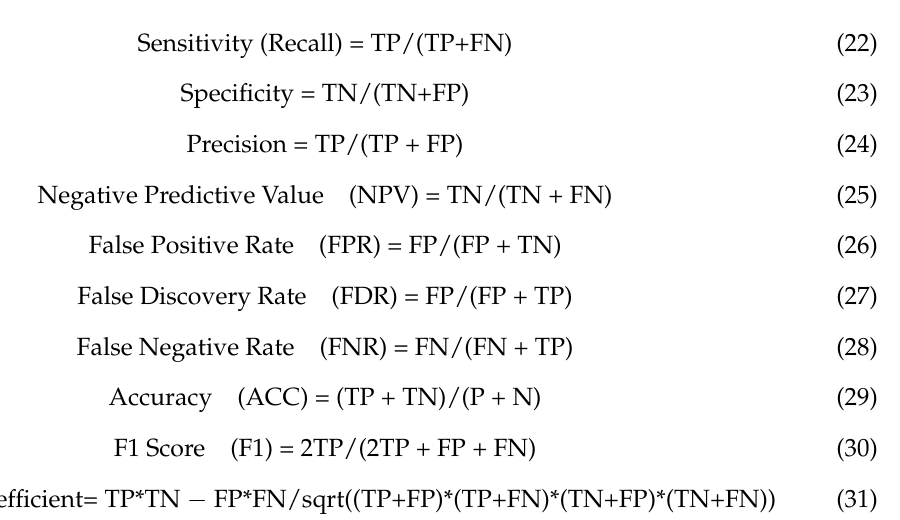
Table 2. Number of sensor activation and activity detection for four different houses equipped with hydrogenous sensing units.